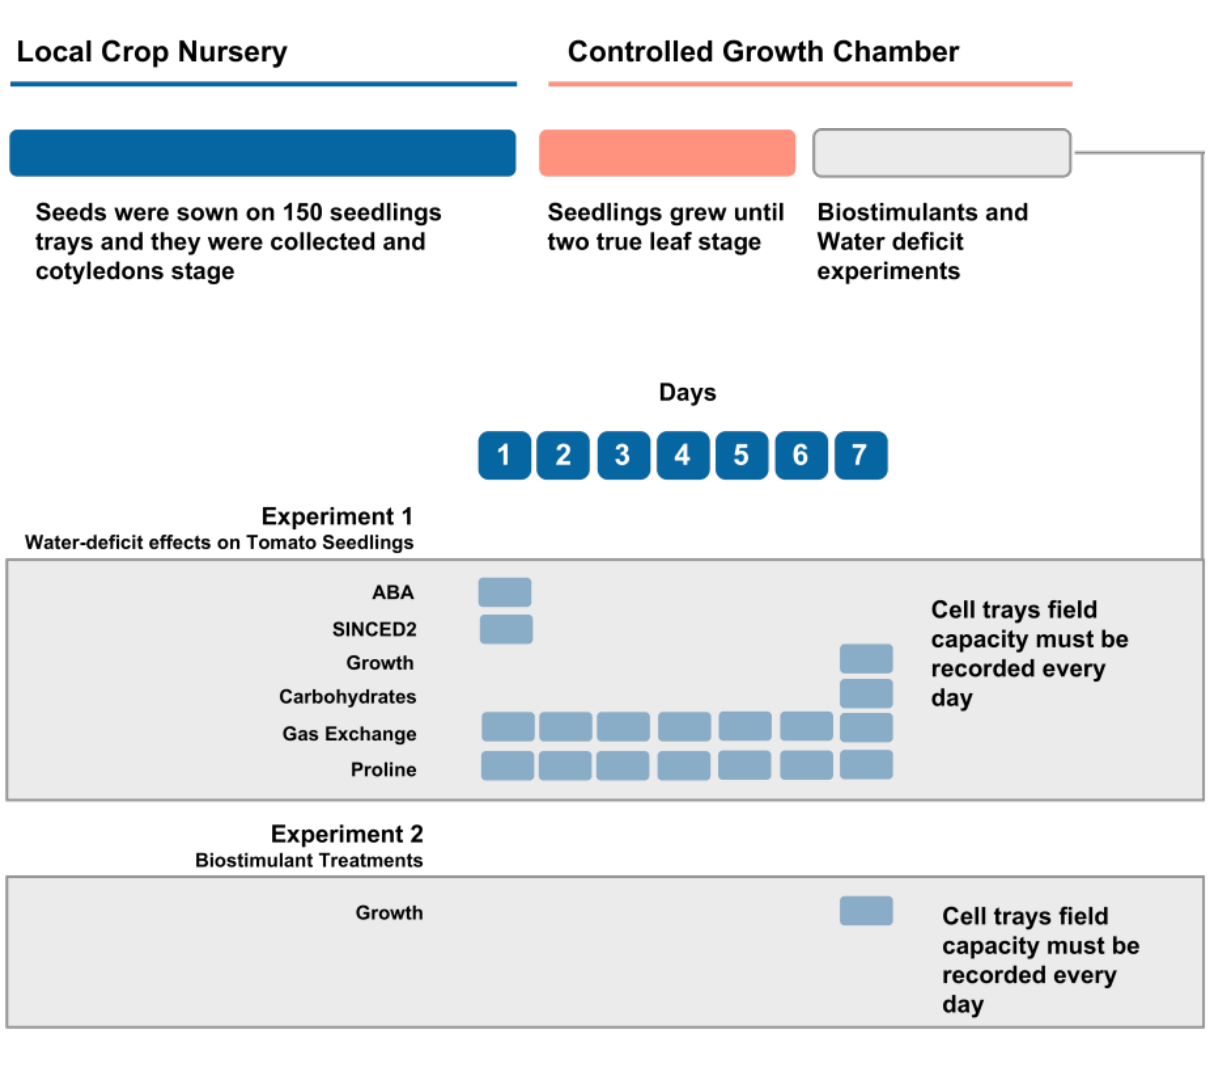
Figure 2. Timeline from local crop nursery to laboratory growth chambers and variables data col- lection